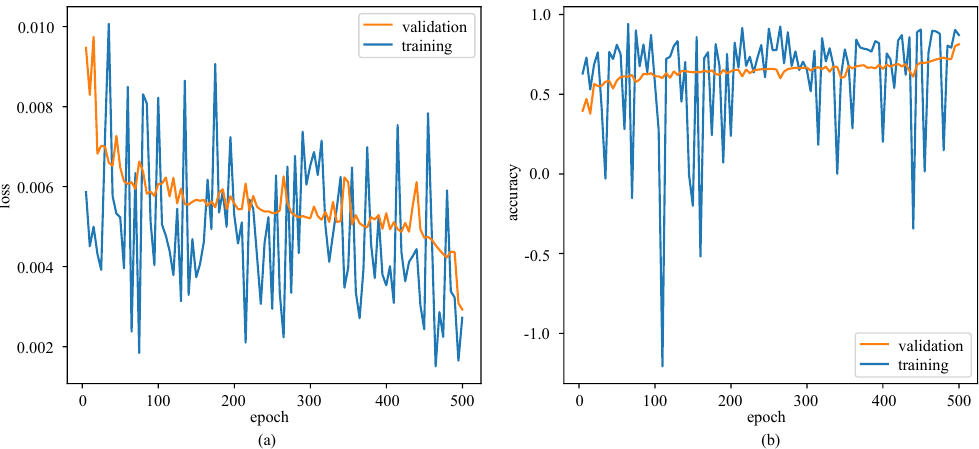
Figure 8. The loss function changes ( a ) and accuracy changes ( b ) over different epoches in training the emotion state representation